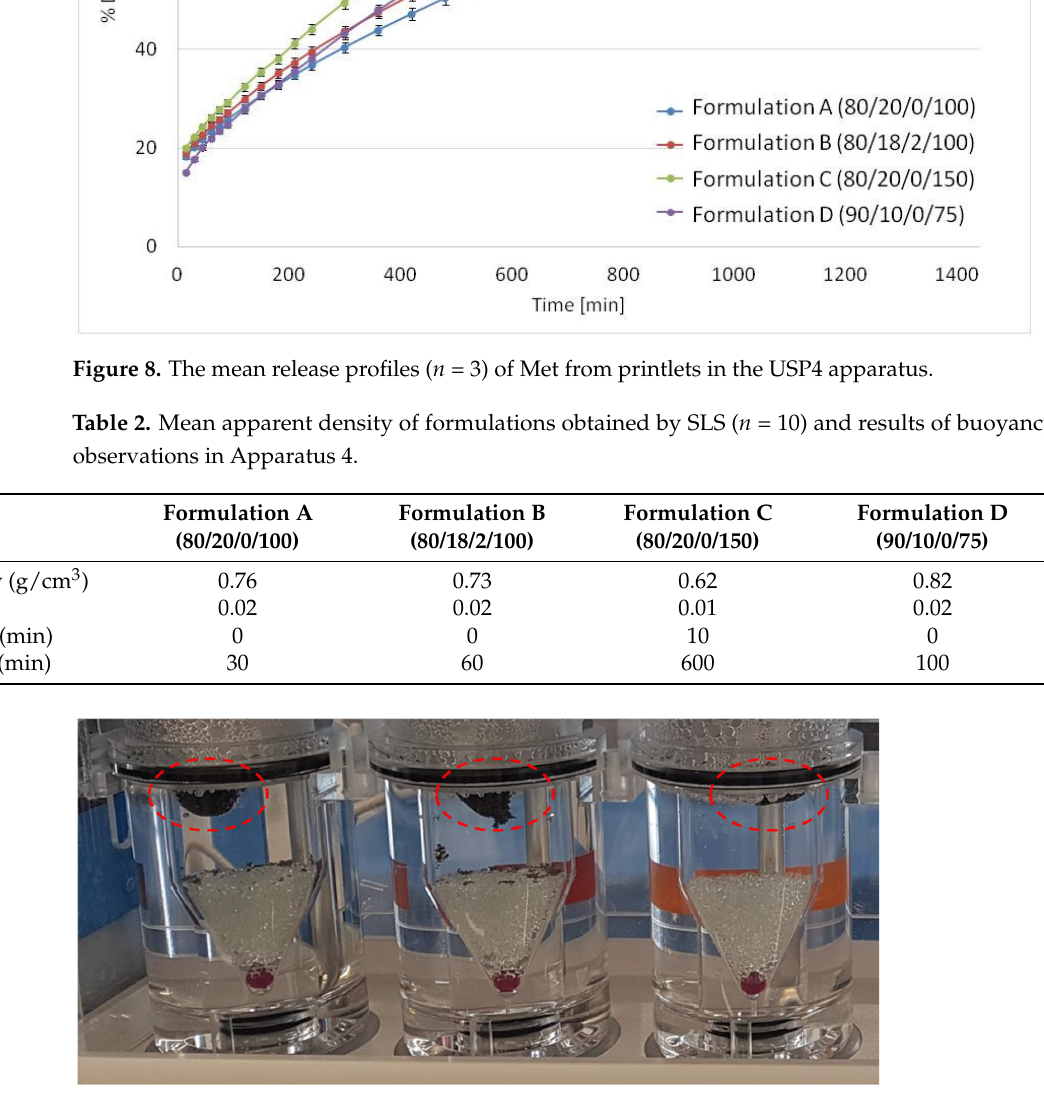
Figure 9. Flotation of Formulation C (80/20/0/150) in USP4 apparatus after 10 h of the experiment. Met release in USP apparatus 3 was substantially faster than in USP4 for all formula- tions due to different hydrodynamic conditions (Figure 10). Dissolution from Formulation A (80/20/0/100) was biphasic. Up to 4 h it was almost linear, and Formulation A released 80% of API at 5 h with the full drug release longer than 10 h. Regarding Formulation C (80/20/0/150), the standard composition containing 80% v/v of Met with higher laser speed (150 mm/s) re- sulted in a much faster Met release—about 80% of the dose was released during the first 30 min, and complete release occurred at 2.5 h. The interesting modification of the 80/20 for- mulation was replacing 2% PA12 with the same volume of sodium chloride as the osmotic agent in Formulation B (80/18/2/100). The presence of sodium chloride in the matrix modified Met release from the printlets. They released about 80% of the API within 1.5 h, and the total Met release was observed at 2.5 h. While the melting point of NaCl is high (801 °C) compared with other components, the addition of NaCl is unlikely to affect the sintering process. The explanation of faster release could be an increase in the osmotic pressure of the solution pre- sent in the porous printlet structure and, consequently, more effective water penetration into the matrix. For formulation containing only 10% v/v of PA12, Formulation D (90/10/0/75), almost 80% of Met was released during the first 2 h. However, in this case, faster release than for 80/20 formulation was probably caused by the weaker composite structure due to the lower PA12 content. Figure 10. The mean release profiles ( n = 3) of Met from 3D printlets in the USP3 apparatus.